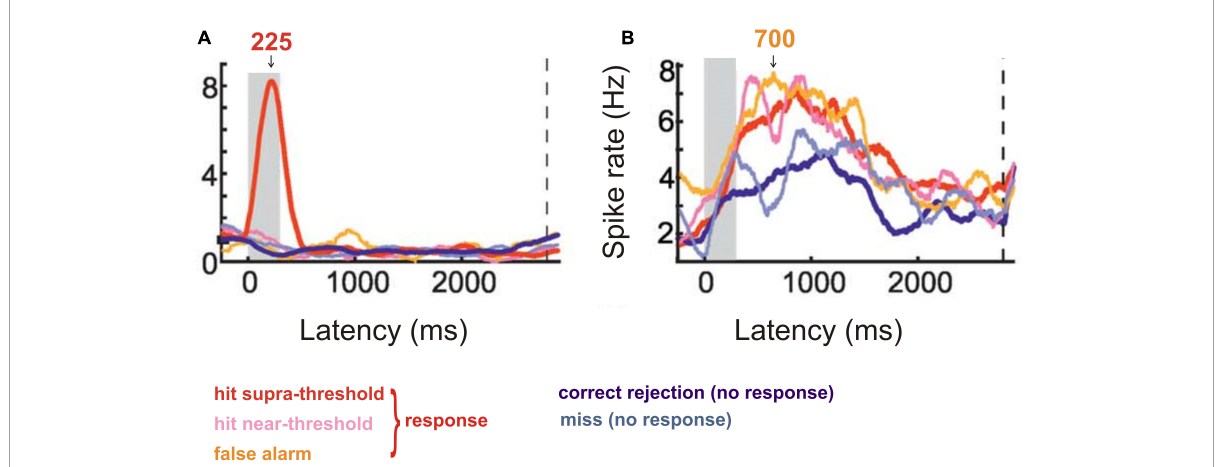
FIGURE3 Response behavior of neurons from the crow nidopallium caudolaterale to visual stimuli in a stimulus detection task. (A) Cumulative spike rate of an example neuron responding only to a highly visible, supra-threshold stimulus with a response peak about 225 ms after stimulus onset (stimulus duration is shown by the gray area). The neurons of this response type signaled the intensity of the correct stimulus and, thus, the ability to become aware of it. (B) Cumulative spike rate of an example neuron responding in the preparation of a response to a perceived (supra-threshold or near-threshold) or allegedly perceived (false alarm) stimulus. The response was trained to be given after a 2800 ms delay from stimulus onset (dashed vertical line in A and B ). Response rates in a latency window of about 380–1000 ms after stimulus onset (see arrow at 700 ms) were significantly higher when the animal responded compared to the cases when it did not respond (correct rejection or miss). The neurons of this type signaled the conscious response preparation. [Modified from Nieder et al. (2020); their Figure 2C (here Figure 3A ) and Figure 2E (here Figure 3B